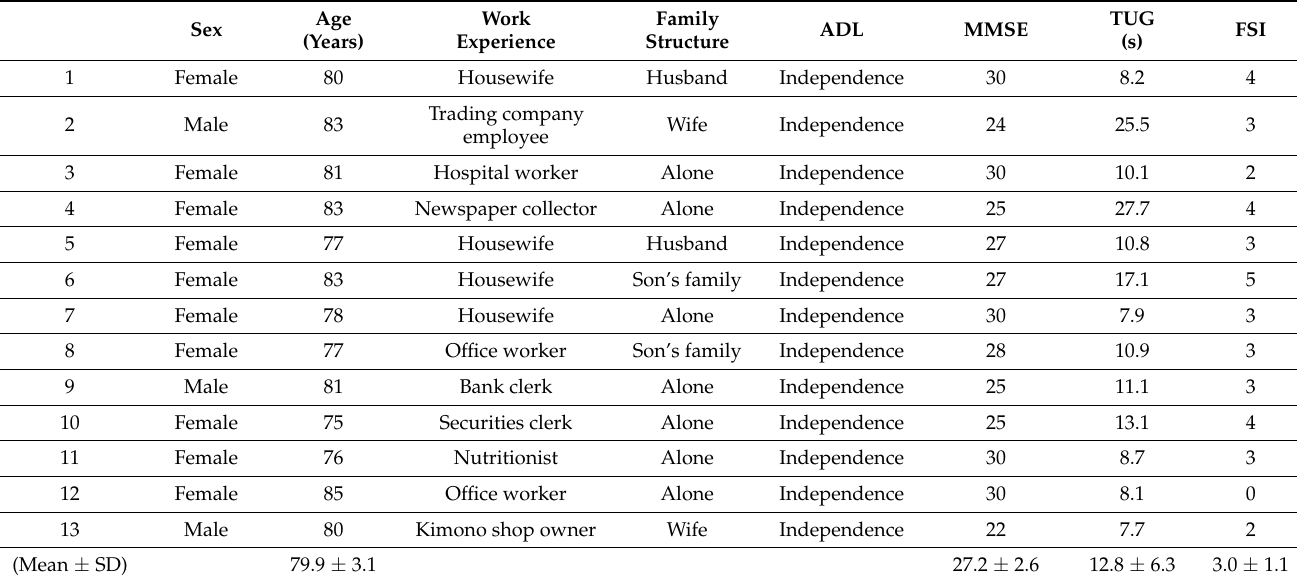
Table 1. Characteristics of